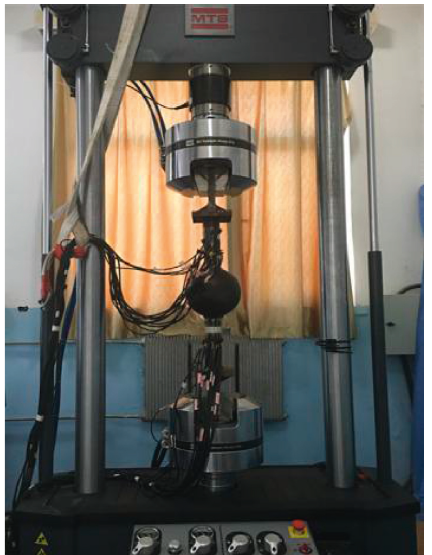
Figure 6: MTS Landmark 370.50 for the fatigue test.